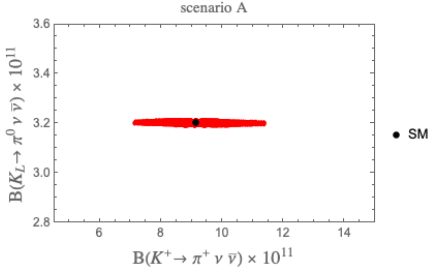
Figure 2 . Scenario A. Correlation between B ( K L ! (cid:25) 0 (cid:23) (cid:22) (cid:23) ) and B ( K + ! (cid:25) + (cid:23) (cid:22) (cid:23) ). The black dot represents the central value of the SM prediction.